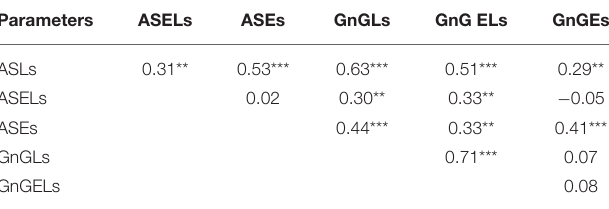
TABLE 6 | Oculomotor parameters correlations.